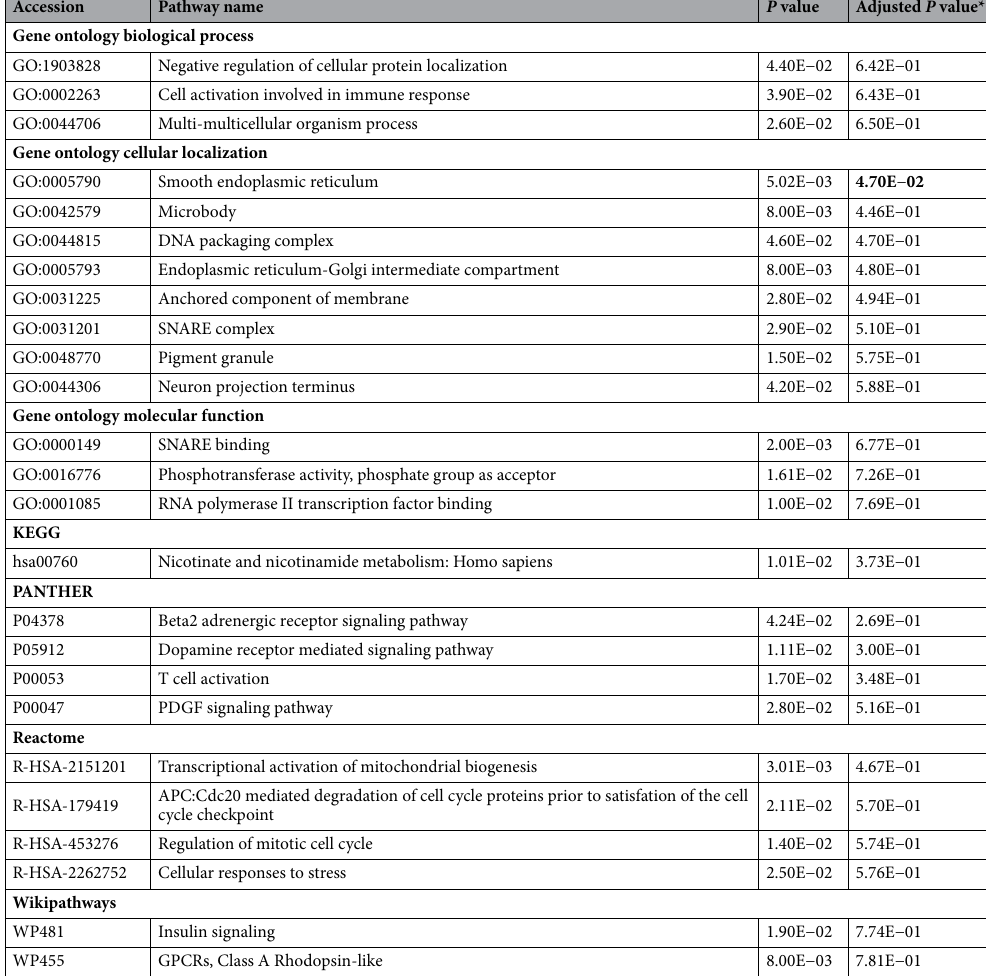
Table 4. Results of rare/low-frequency variants analysis: a list of the most significantly enriched pathways ( P value < 0.05) from gene set enrichment analysis using WebGestalt. SNARE soluble N-ethylmaleimide- sensitive factor attachment protein receptor, PDGF platelet-derived growth factor, APC/C anaphase-promoting complex, GPCR G-protein-coupled receptor. *By Benjamini–Hochberg procedure. Numbers in bold indicate the smallest adjusted p -values, i.e. most significant pathway enrichments among all rows in the